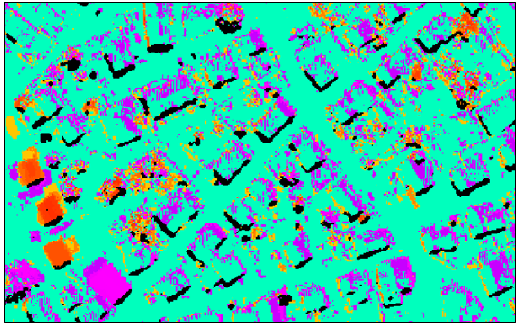
Figure 3: A portion of the difference